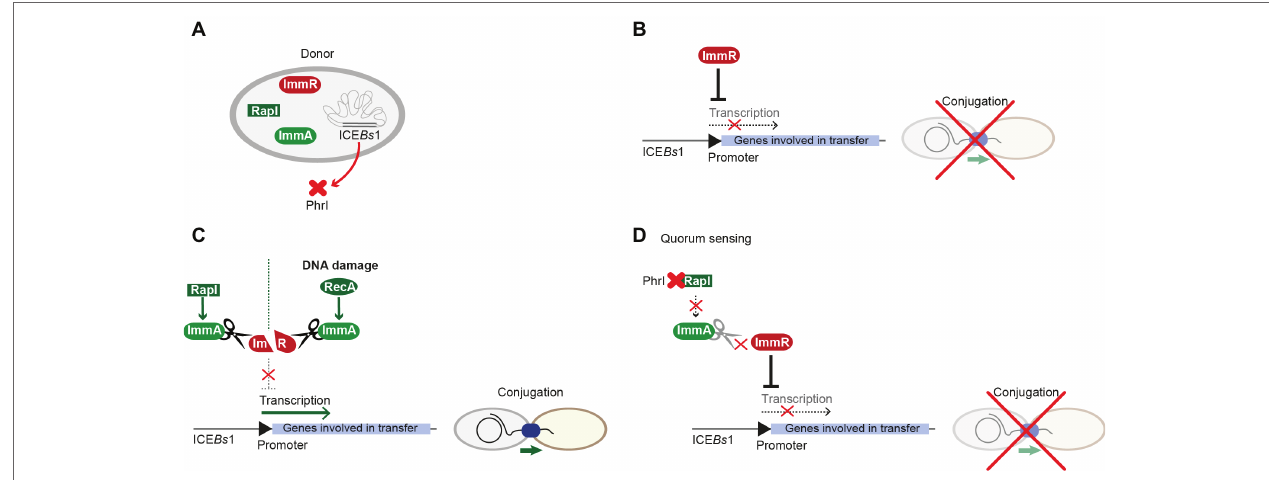
FIGURE 5 | Regulation of ICE Bs 1 conjugative transfer. (A) ICE Bs 1 harbors most key players involved in regulation of conjugative processes, including the master-regulator ImmR, the metalloprotease ImmA, and the RapI-PhrI sensor-pheromone cassette. (B) Similar to processes in pLS20, the master-regulator ImmR represses transcription of genes involved in mobilization and transfer, which ultimately leads to inhibition of conjugation. (C) RapI or RecA that is activated by general DNA damage control proteolytic cleavage of ImmR by the metalloprotease ImmA. Thus, transcription is activated and conjugation can take place. (D) Upon a distinct concentration (the quorum), the signal peptide PhrI binds to RapI, interfering with its ability to activate ImmA; thus, ImmR can exert repression of the promoter as described in (A)